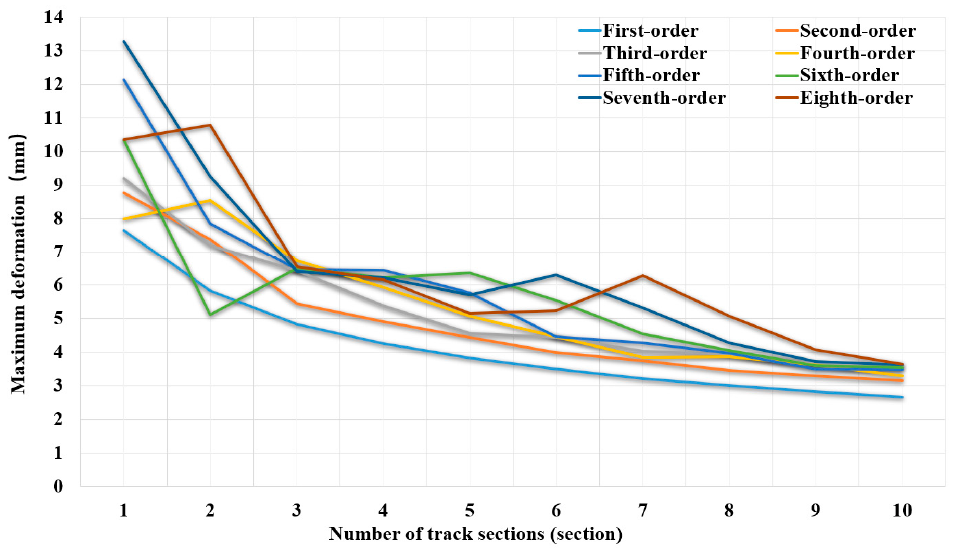
Figure 4. The mass normalized vibration modes of different section tracks.